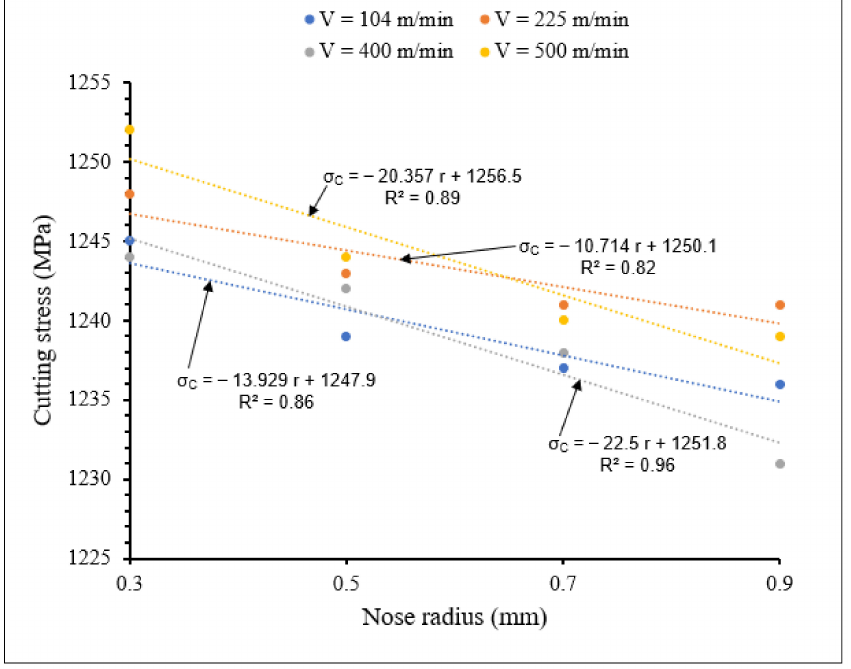
Figure 19. Variation of cutting stress with large tool nose radius for different cutting speeds at f = 0.1 mm/rev, γ = 5 ◦